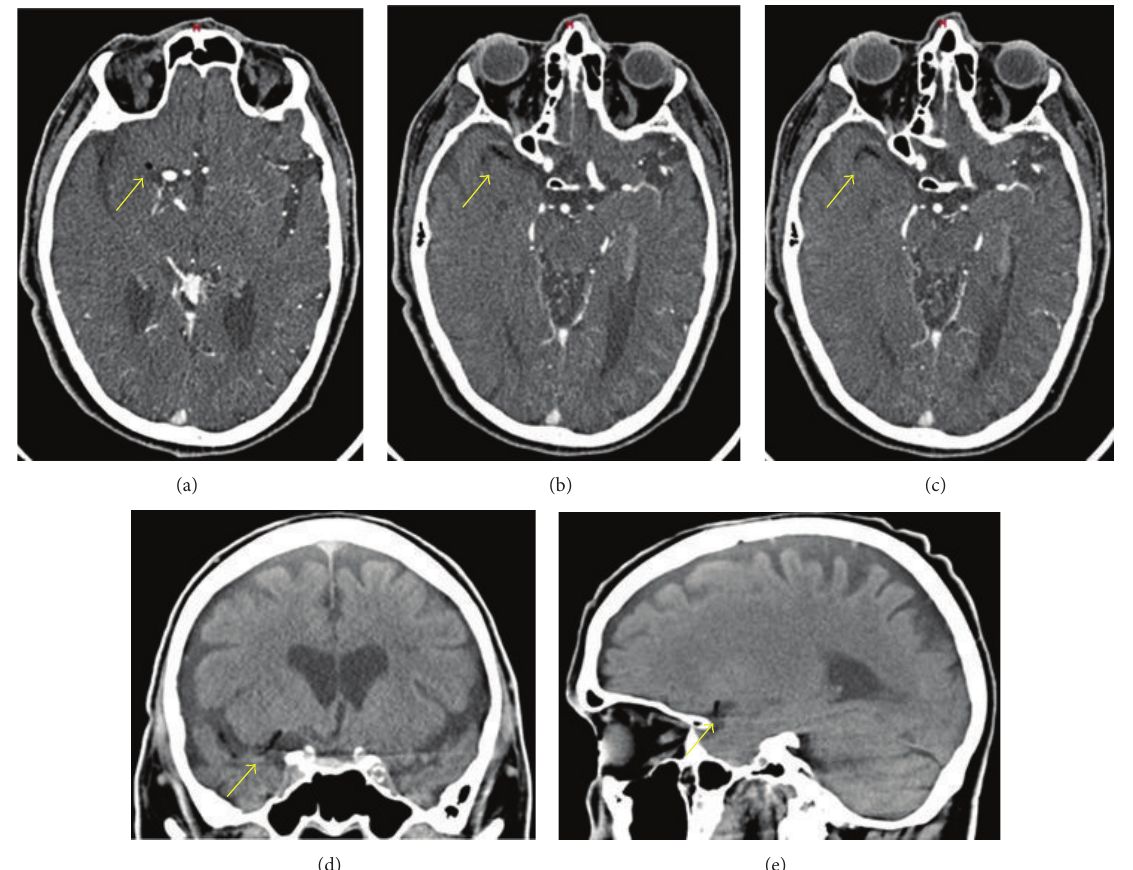
Figure 1: Computed tomography: axial ((a), (b), and (c)), coronal (d), and sagittal section images (e). Hypointense image is observed at the birth of the MCA (yellow